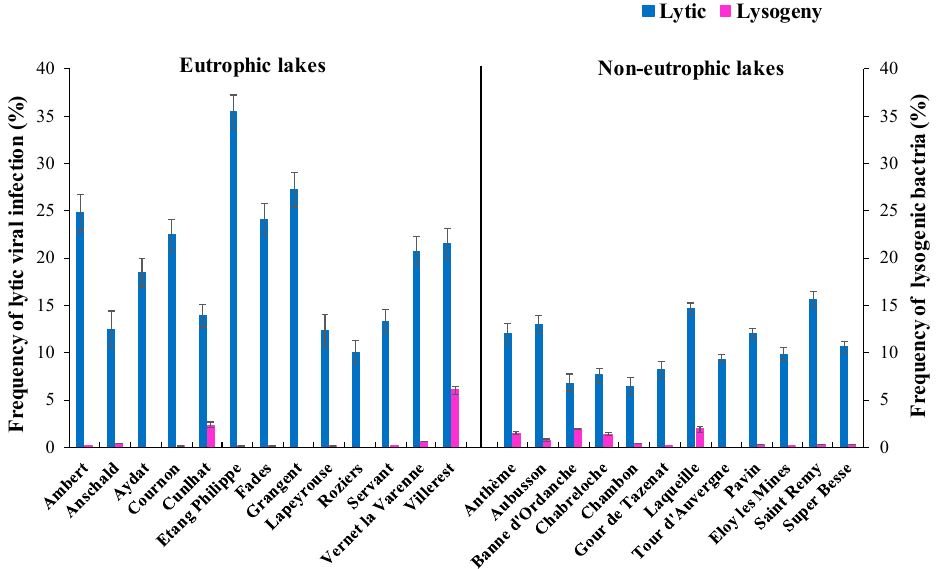
Figure 3. Frequency of lytic viral infection and lysogeny in the eutrophic and non-eutrophic set of lakes. Data represent mean ± SD (n = 3).